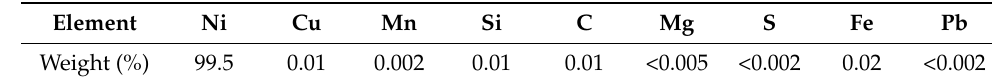
Table 1. Chemical composition of Ni.